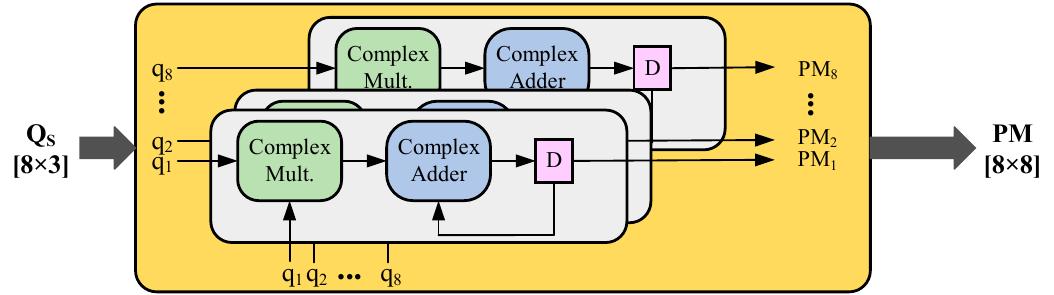
Figure 17. Linear systolic array design for the PM Figure 17. linear systolic array design for the PM module.